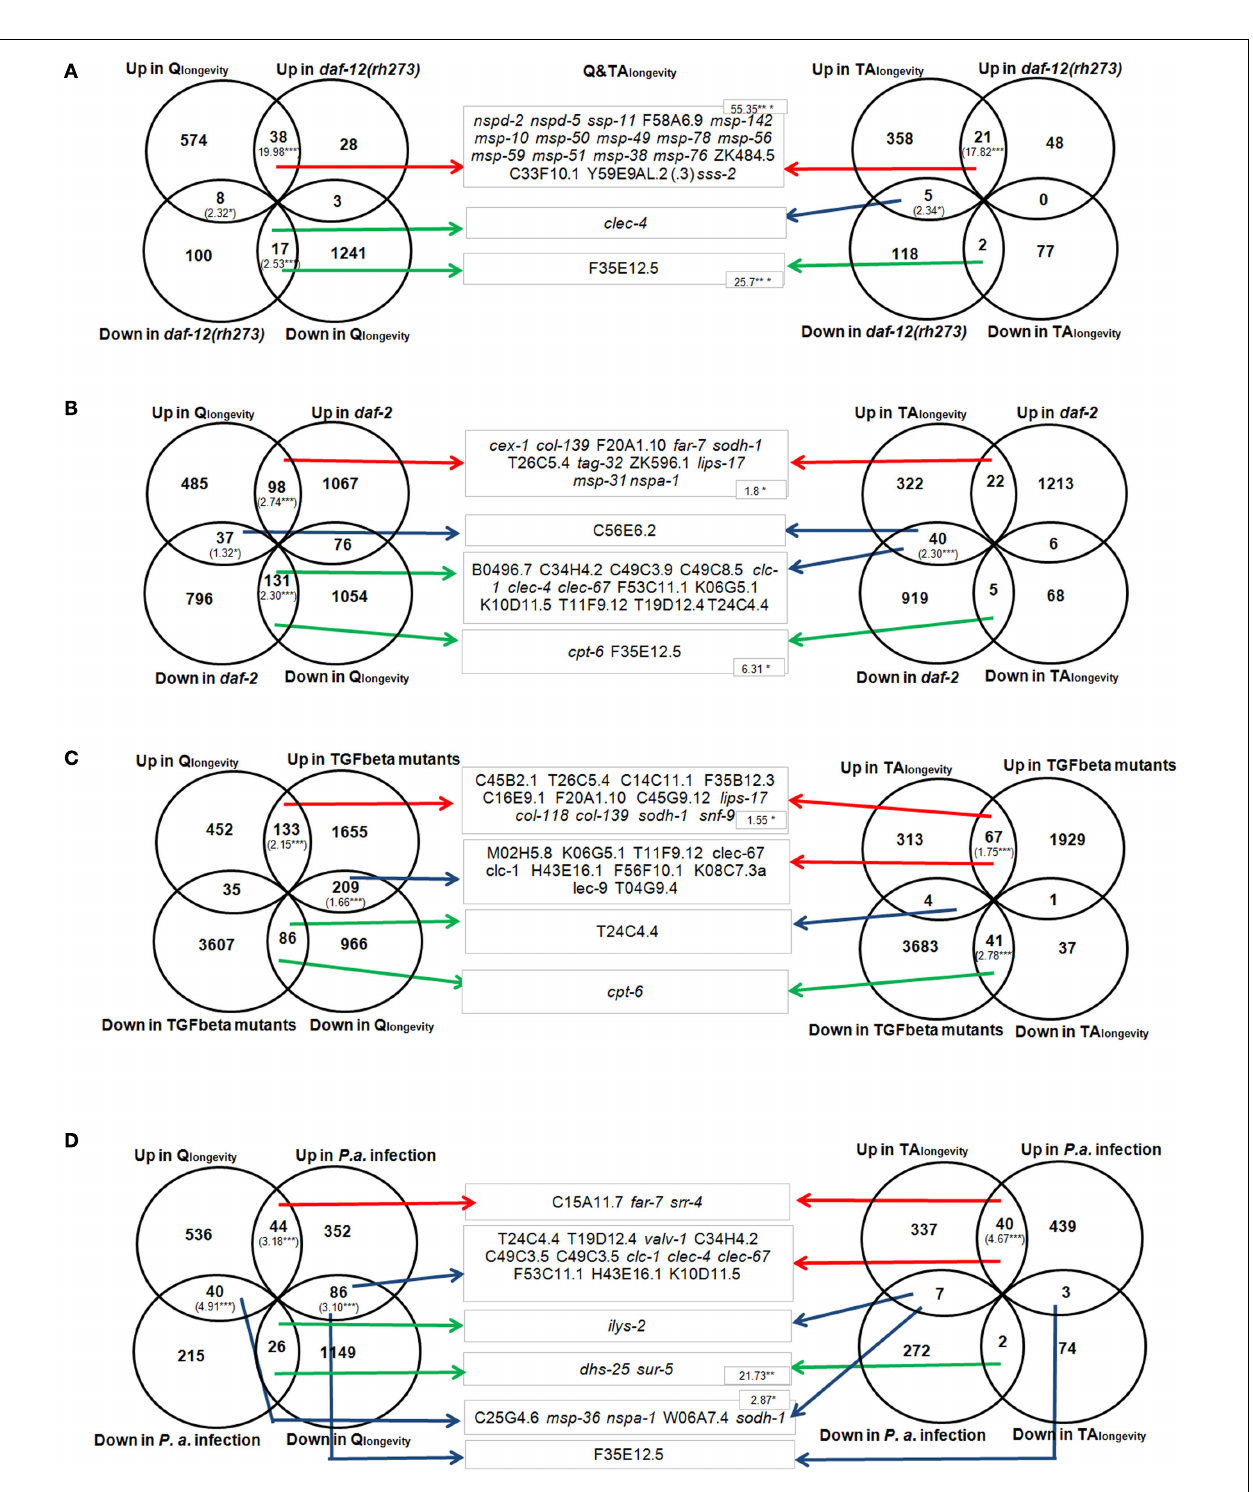
DEGs that are regulated in opposite directions.The overlap is significant where RF values (numbers in brackets) are shown. ∗ p < 0.05, ∗∗ p < 0.005, ∗∗∗ p < 0.001. (Additional information about all RF values in single PP concentrations and published data can be found in Supplementary Material 4: sheet “Meta-Analysis.” A GO- and InterPro-cluster analysis of overlapping DEGs in respective intersections can be found inTable S4 in Supplementary Material 1. All results can be reconstructed using the filter function in Supplementary Material